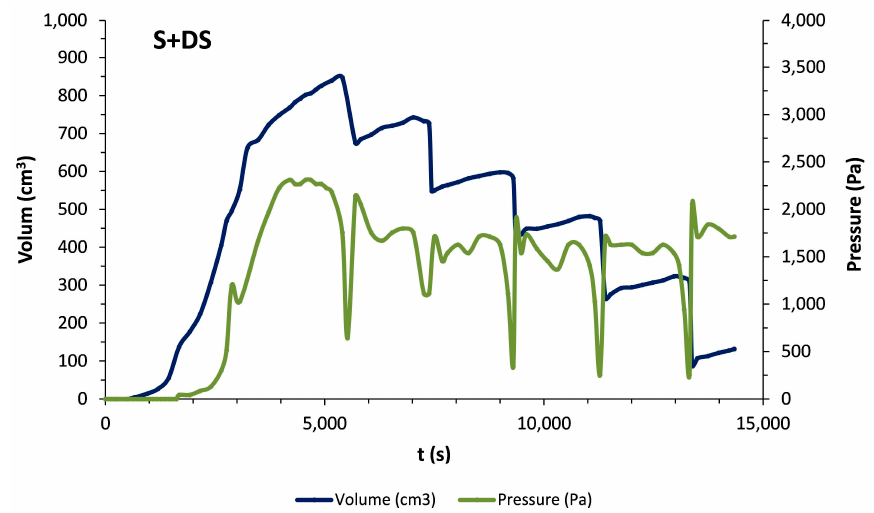
Figure 20. Volume of liquid accumulated in the tray and pressure in the S+DS porous medium: z = 3.364 cm to the heating plate, piezometer